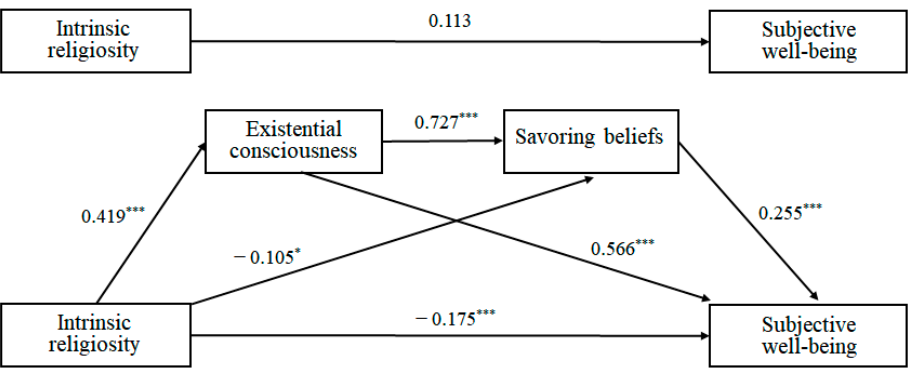
Figure 2. The double mediation model of existential consciousness and savoring beliefs on the religiosity and subjective well-being of middle-aged Korean women (* p < 0.05, *** p < 0.001; note: standardized coefficients).